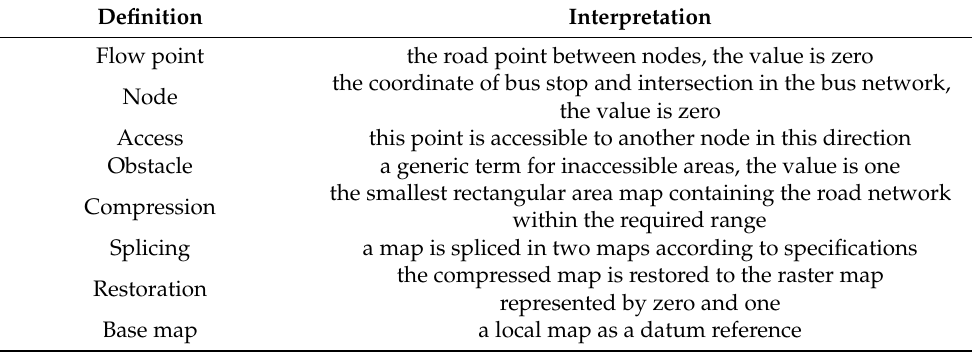
Table 1. Definition